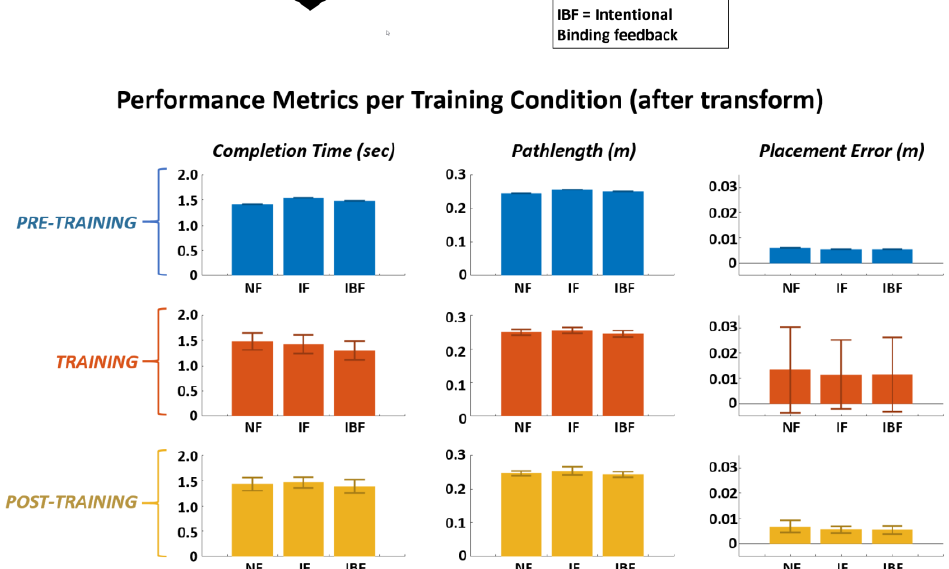
Figure 4. Mean values shown for performance metrics ( completion time, pathlength, and placement error ) across trial-blocks in time ( pre-training, training, post-training ). Data shown as original raw values (TOP) and after transformation (BOTTOM). For data transformation, mean pre-training value for each subject utilized to normalize training and post-training values for same subject. Metric values then de-normalized by multiplying the mean pre-training value for entire subject group. The mean pathlength, completion time, and placement error prior to training Table 3. Repeated measures ANOVA across trial-block times (pre-training, training, post-training) for each performance metric and training condition (feedback mode); Trial-Block Time Indices: 1 = Pre-training, 2 = Training, 3 = Post-training; Feedback Modes: NF = No Feedback, IF = Immediate Feedback, IBF = Intentional Binding Feedback; ‘Difference’ is computed from performance metric value for Time 1 – Time 2.